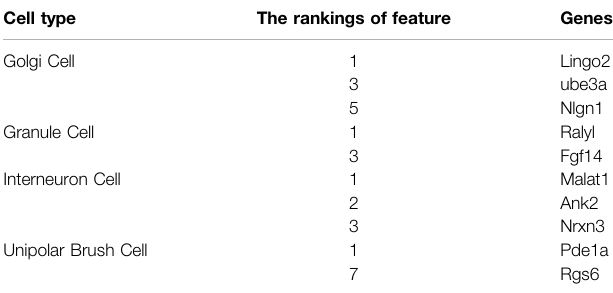
TABLE 3 | Feature list of important genes based on mRMR